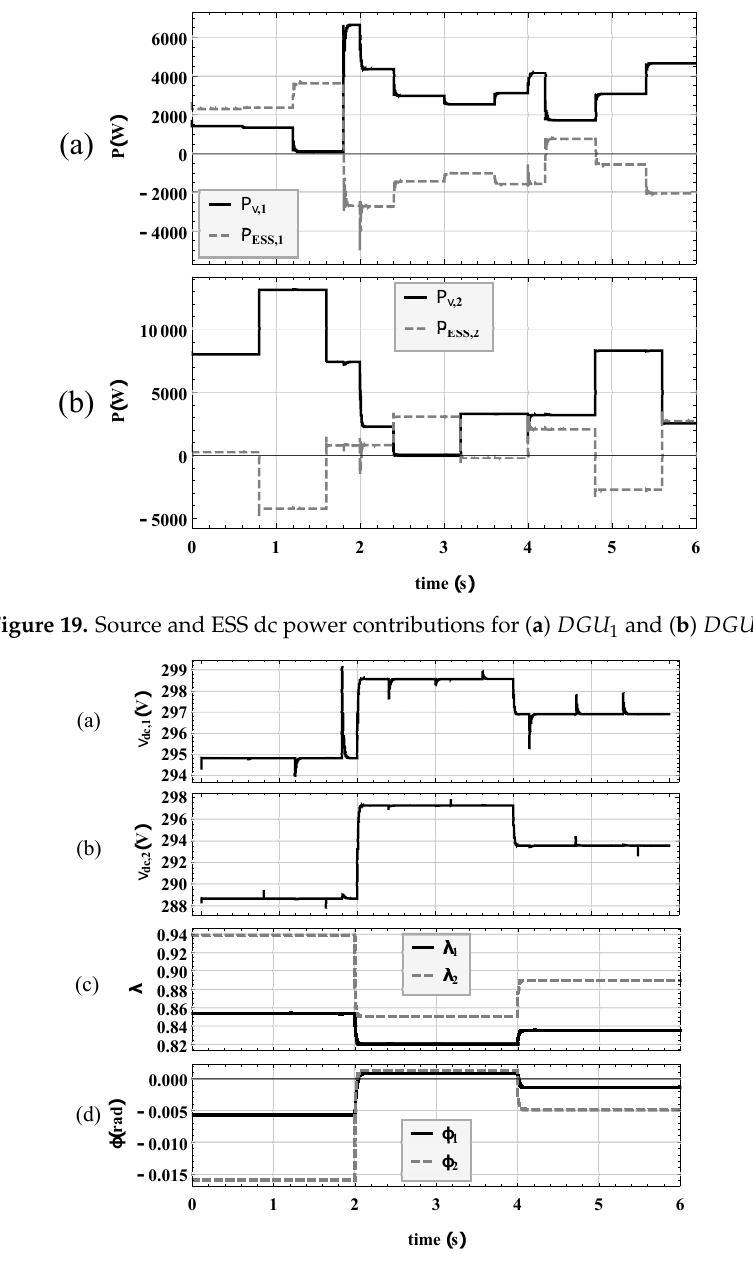
Figure 20. dc-link voltages for ( a ) DGU 1 and ( b ) DGU 2 . Individual inverter commands ( c ) λ 1 and λ 2 , ( d ) φ 1 and φ 2